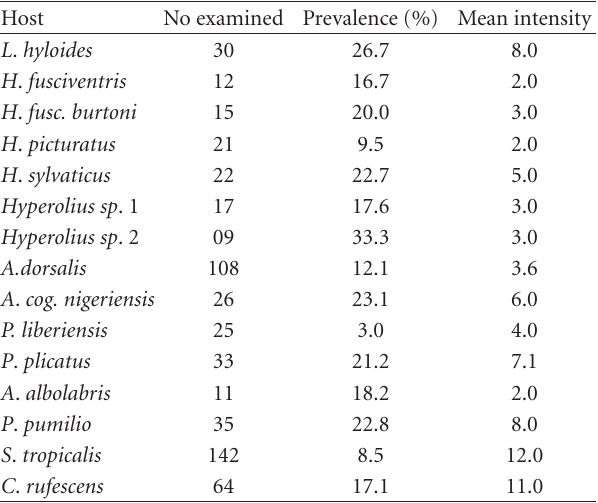
Table 5: Prevalence of acanthocephalan cysts in anurans at the Okomu National